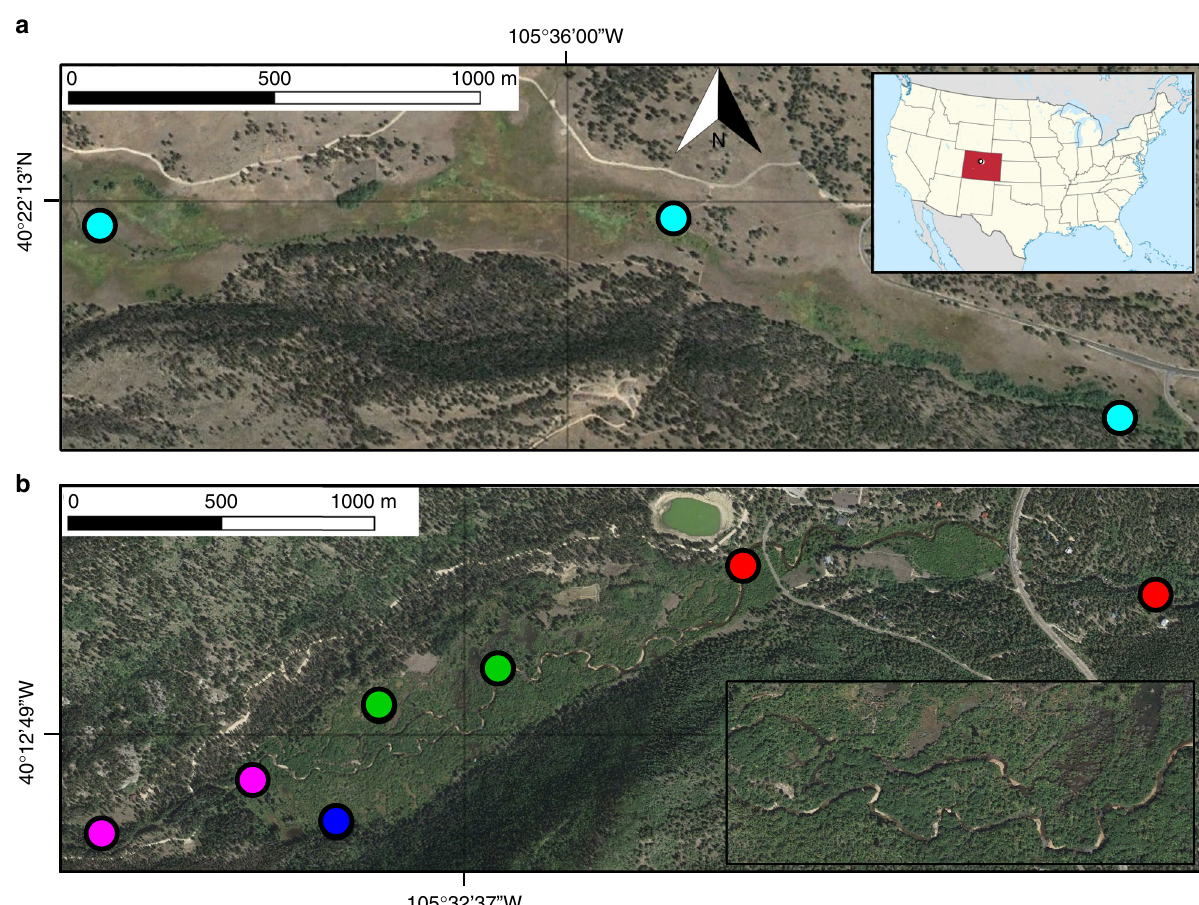
Fig. 1 Site map of the simple and complex river channel networks sampled for this study. a From the simple network (Upper Beaver Meadows; UBM), we present data from three single-channel sites (light blue symbols). b From the complex network (North Saint Vrain Creek; NSV), we present data from two main channel sites in the upper con fi ned segment (pink symbols), two side-channel features (green symbols), and a disconnected beaver pond (blue symbol) in the active beaver meadow complex, and two main channel sites in the lower con fi ned segment (red symbols). Symbol colors match Fig. 3. The headwaters of UBM and NSV are located in Rocky Mountain National Park, Colorado, USA. Map data ©2018